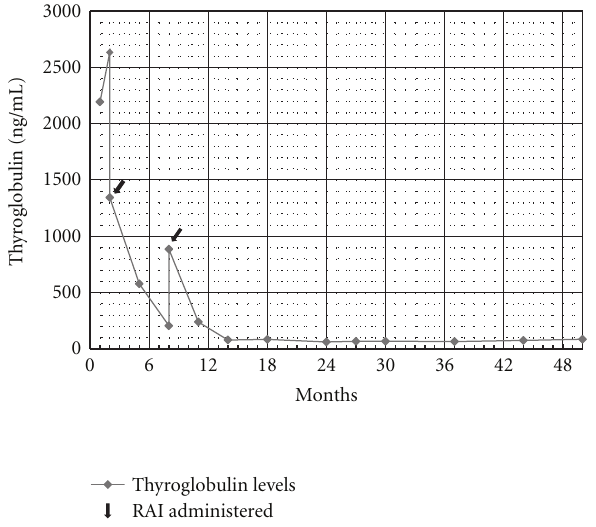
Figure 3: Trend in serum thyroglobulin level over